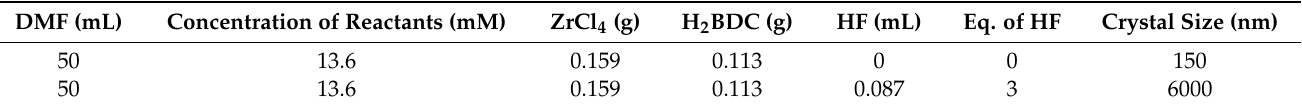
Table 1. The amounts of reactants and HF modulator in UiO-66